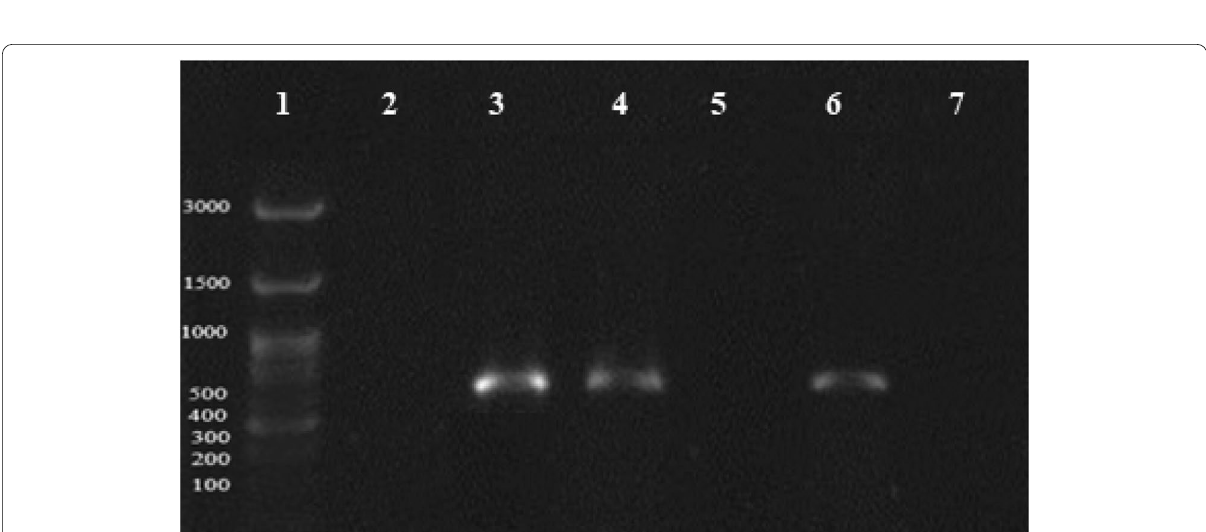
Fig. 5 PCR product electrophoresis for the study of bla CTX-M gene on 1% agarose gel; lane 1, DNA marker (ladder 100 bp: SMO321 , Fermantas ); lane 2, negative control; lanes 3, 4, and 6, positive bla CTX-M : 544